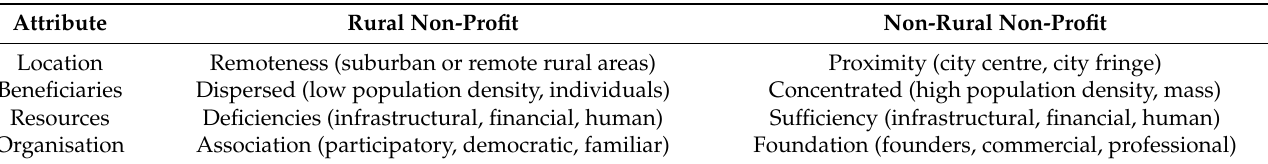
Table 1. Main differences between rural and non-rural